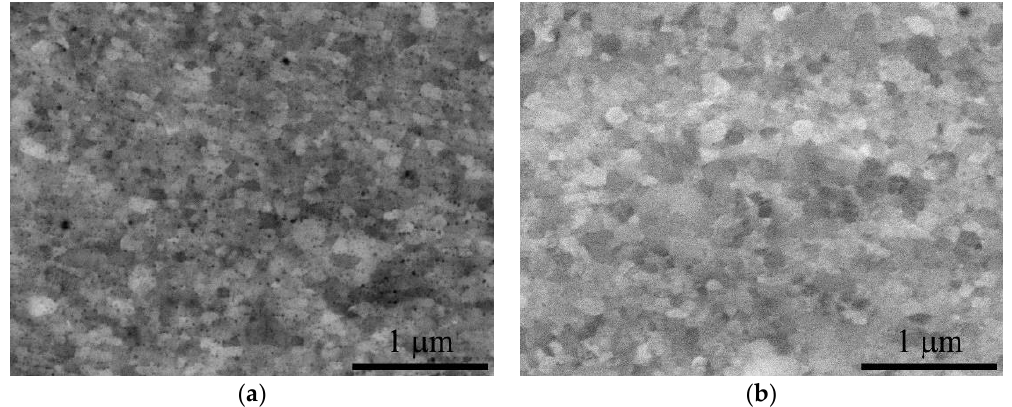
Figure 1. Microstructures of the consolidated ( a ) Fe-11Al-1O and ( b ) Fe-17Cr-7Al-4Y 2 O 3 .